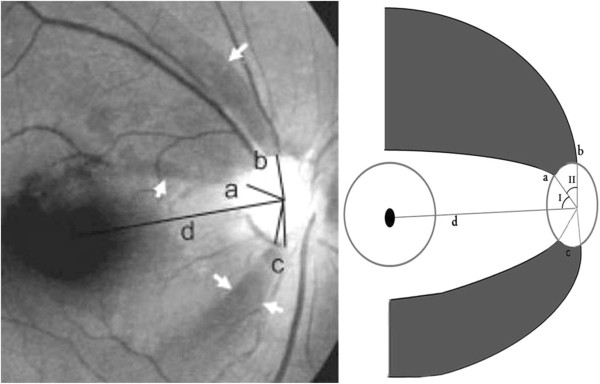
Parameters for retinal nerve fiber layer (RNFL) photography [[15]]. Reference line d extends from the center of the disc to the center of the fovea. Angle I is the minimum angle between the reference line and a line from the disc center to the point of the disc margin nearest the border of the defect. Angle II is the sum (b + c) of the angular widths of the defects.